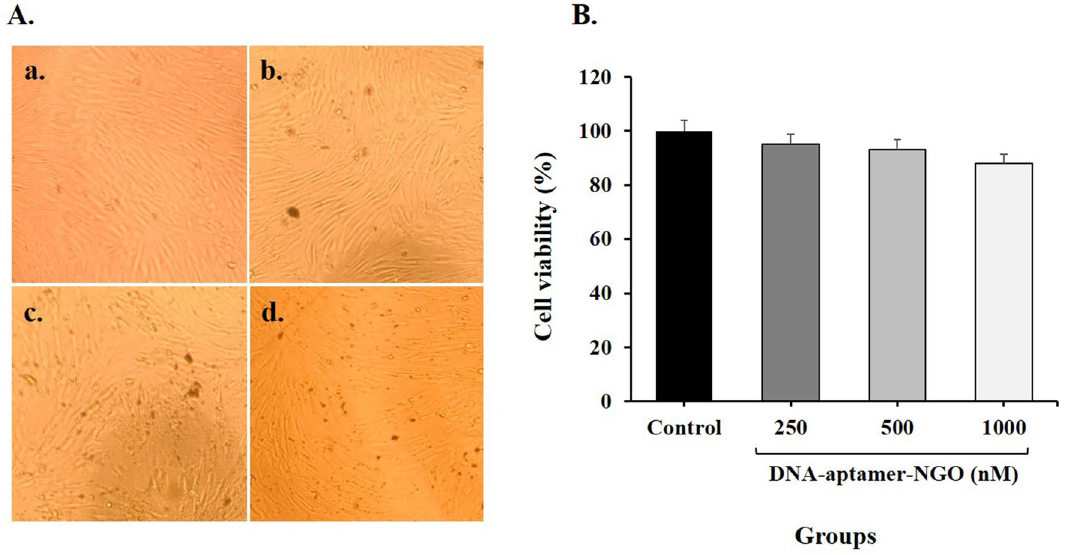
Figure 8. Effects of DNA-aptamer-NGO on cell viability of primary human gingival fibroblast (HGF) cells: ( A ) Inverted light microscope images of treated cells with varying concentrations of DNA-aptamer-NGO (250, 500, and 1000 nM; magnification × 40); (a) Control (Untreated cells), (b) 250 nM, (c) 500 nM, and (d) 1000 nM. ( B ) The mean percentage viability of HGF cells versus concentrations of DNA-aptamer-NGO (250, 500,